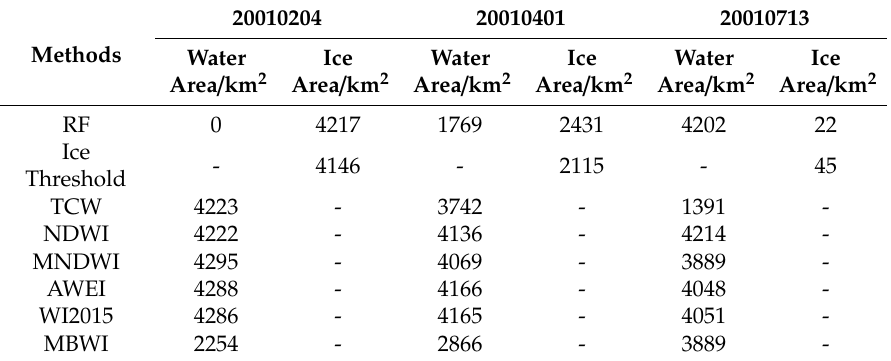
Table 4. Comparison of water and ice area derived from di ff erent methods on three